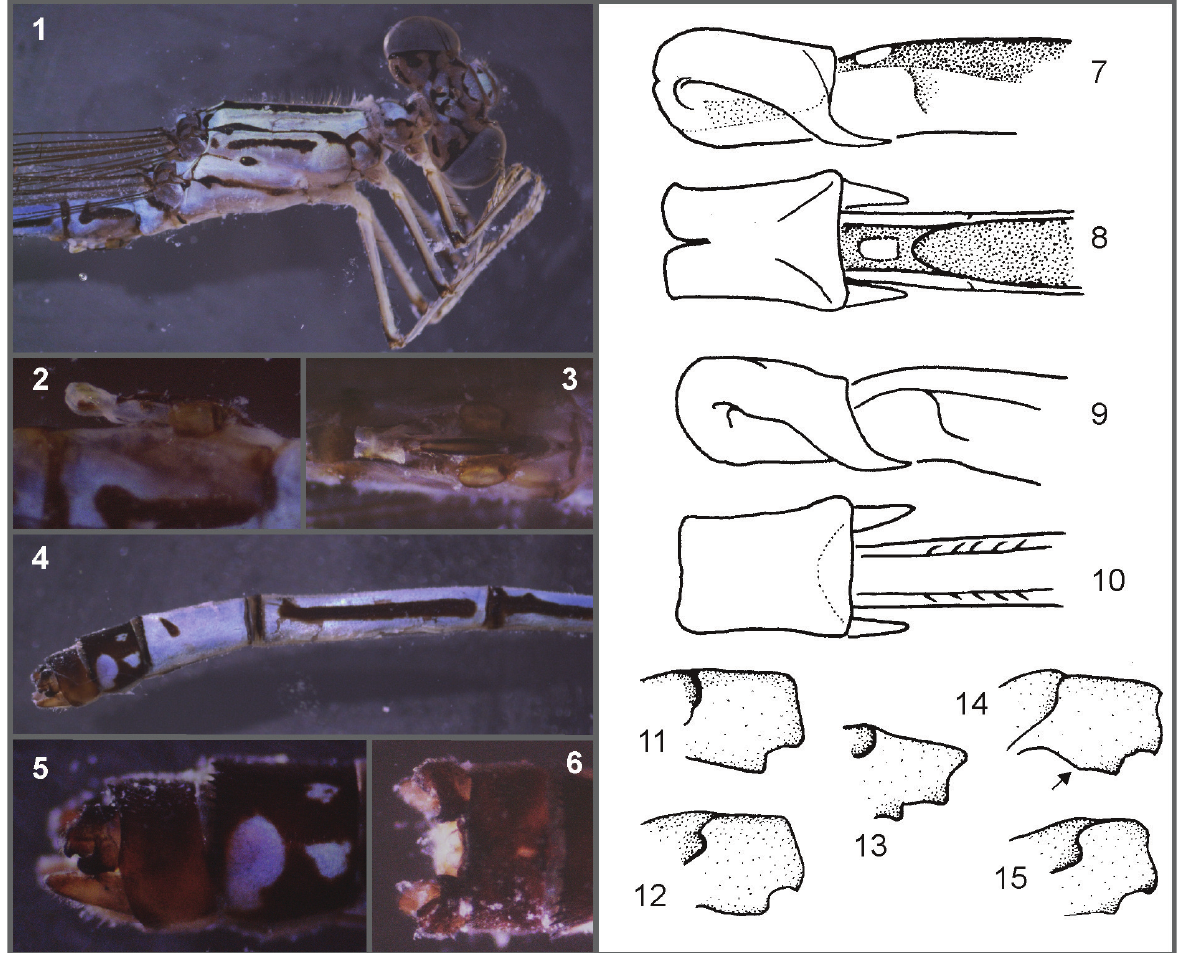
Figures 1-15 - Neoneura confundens , male adult (Argentina, Tucumán): 1 , head and thorax; 2 , ligula, lateral view; 3 , ligula, ventral view; 4 , abdominal S7-10, lateral view; 5 , detail of S9-10, cercus and paraprocts, lateral view; 6 , details of S10, cerci and paraprocts, dorsal view. Mature male: 7 , ligula, lateral view; 8 , ligula, ventral view; 11-12, cercus, inner latero-dorsal view. Teneral male: 9 , ligula, lateral view; 10 , ligula, ventral view; 13 , cercus, inner latero-dorsal view. Mature male: 14-15 , cercus, inner latero- dorsal view (arrow indicates remnants of a third